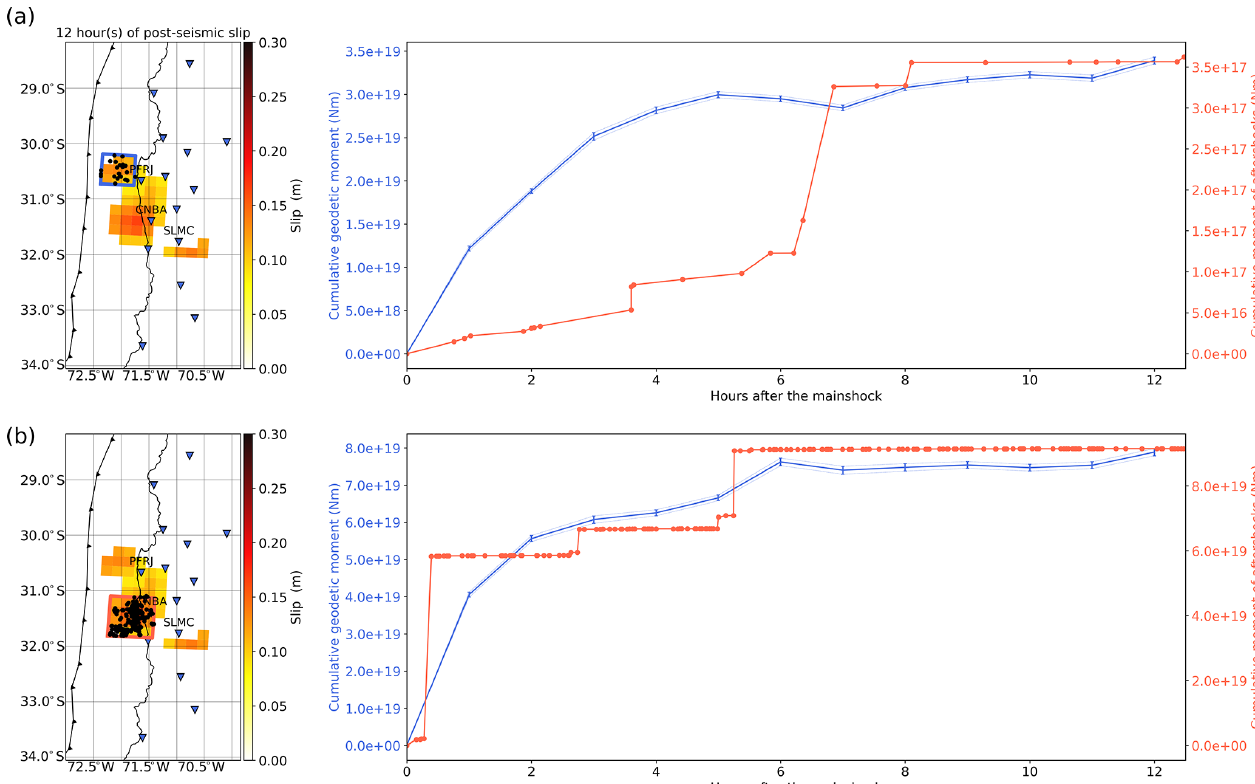
Figure 6. (a) On the left, we show a map highlighting the region considered for the calculations (blue square) that we define as the northern patch in the main text. On the right, we show the time evolution of the geodetic moment (blue curve) along with the time evolution of the seismic moment from the aftershocks (red curve). (b) On the left, we show a map outlining the region considered for the calculations (red square) that we define as the southern patch in the main text. On the right, we show the time evolution of the geodetic moment (blue curve) along with the time evolution of the seismic moment from the aftershocks (red